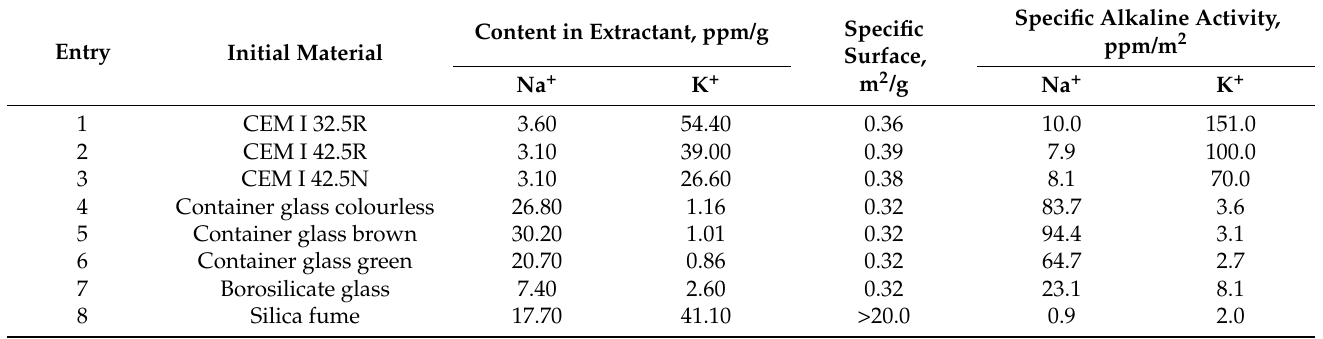
Table 2. The alkaline activity of materials used for the production of cement